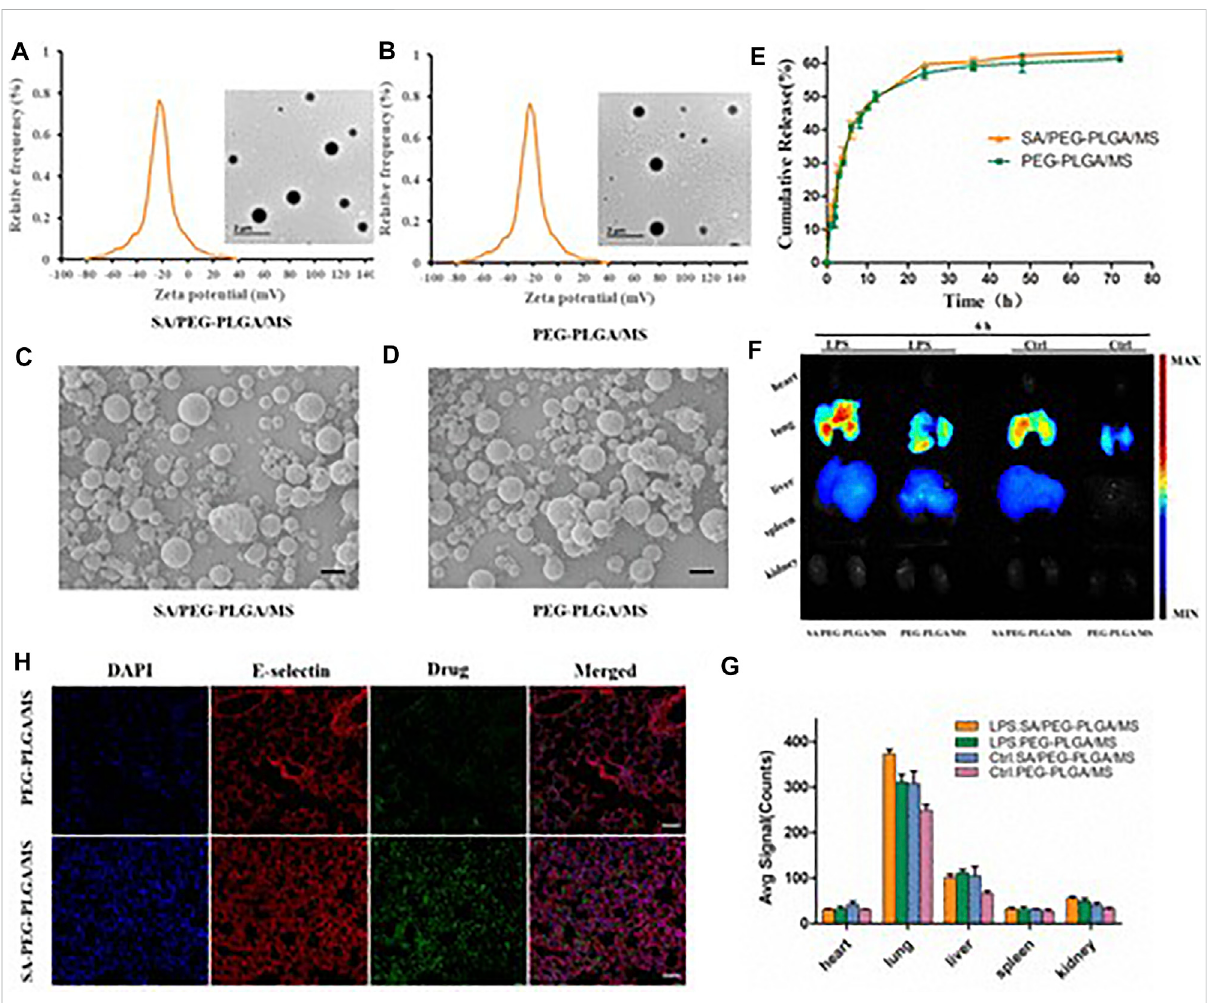
FIGURE 3 Sialicacidmodi fi edmicrospherefabricationandcharacterization.Zetapotentialofsialicacidmodi fi edPEG-PLGAmicrospheres (A) ,PEG-PLGA microspheres (B) , obtained by DLS, and the inserted images were obtained by TEM (scale bar = 1 μ M). The morphology of SA/PEG-PLGA/MS (C) and PEG-PLGA/MS (D) were observed by SEM (scale bar = 1 μ M). (E) In vitro release manner of Cur-TPP from SA/PEG-PLGA/MS and PEG-PLGA/MS. (F) Bio-distributionofSA/PEG-PLGA/MS invivo .The fl uorescenceimagesofexcisedorgansfrommicetreatedwithLPSornot. (G) Thequantitative analysis of fl uorescence intensity in heart, lung, liver, spleen and kidney of Figure 2F. ( n = 3) (H) Imaging of E-selectin receptors stained with a fl uorescent E-selectin antibody with Cur-TPP loaded microspheres, and nuclei were stained with DAPI. (scale bar = 50 μ m) (Jin et al., 2019). It was